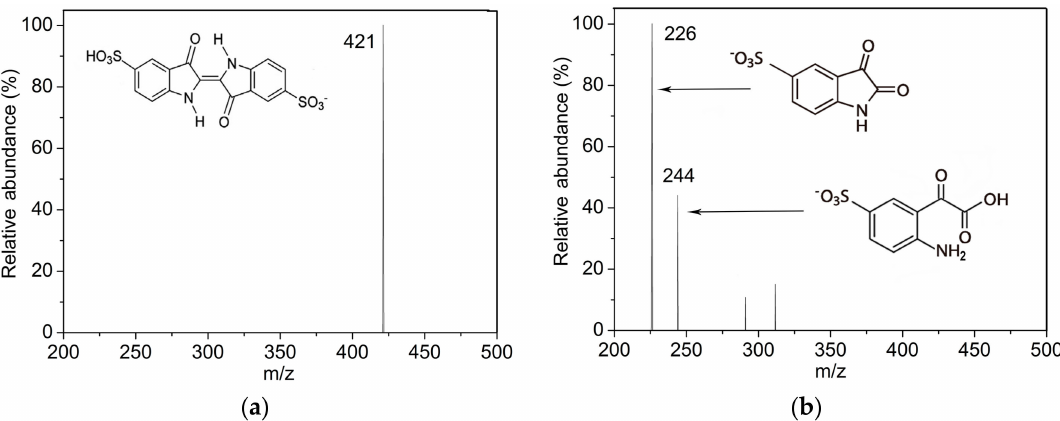
Figure 6. Mass spectra of indigo carmine before ( a ) and after ( b ) treatment by